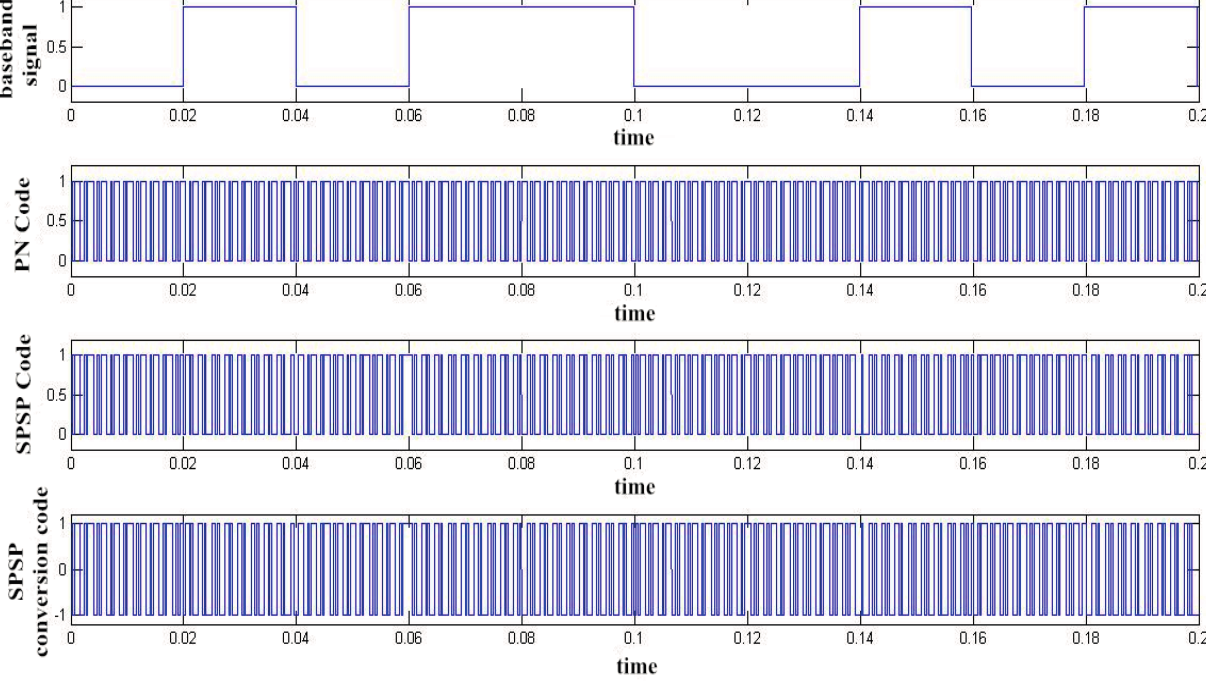
Figure 14. Simulation result of Spread Spectrum (SPSP).